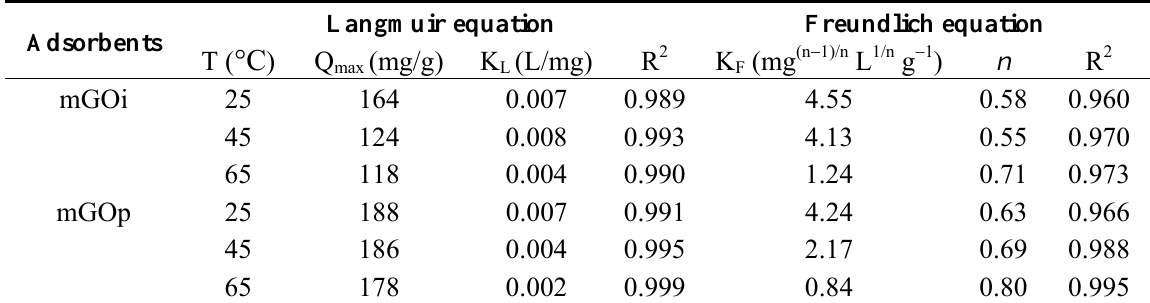
Table 2. Equilibrium parameters for the adsorption of RB5 onto mGOi and mGOp at 25, 45 and 65